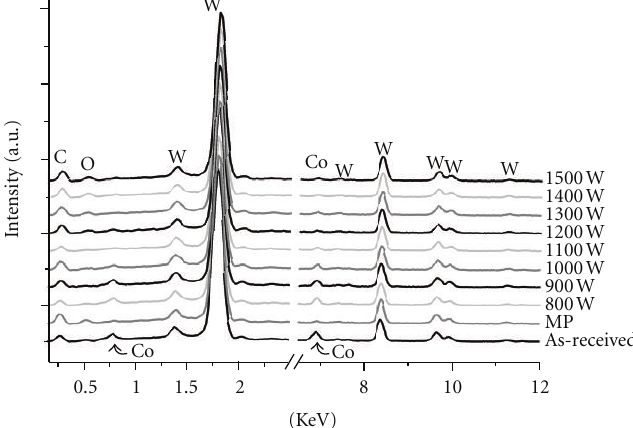
Figure 10: EDS of as-received, MP-treated and laser-treated WC-Co